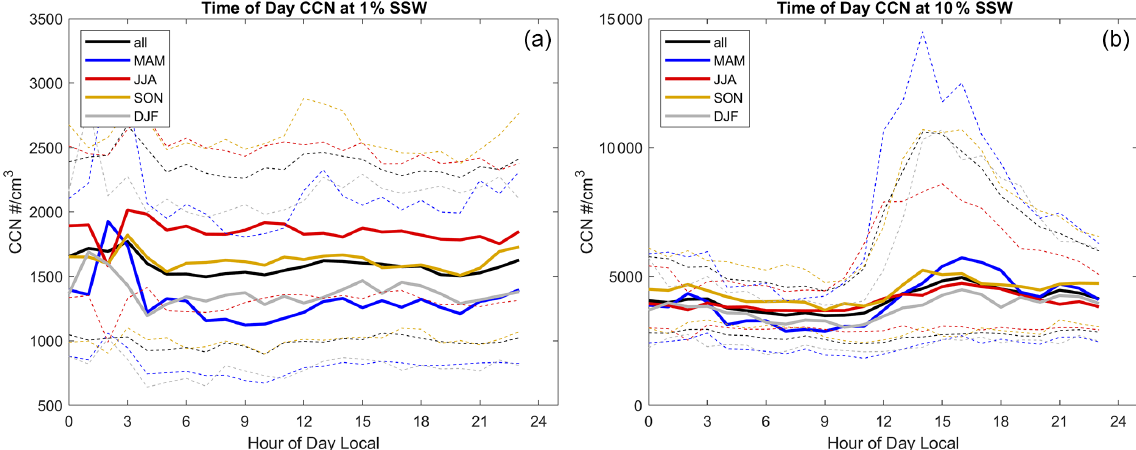
Figure 7. Median (solid lines) and 75% confidence intervals (dotted lines) with seasonally averaged CCN concentrations at 1% (a) and 10% (b) SS w , as a function of the local time of day.